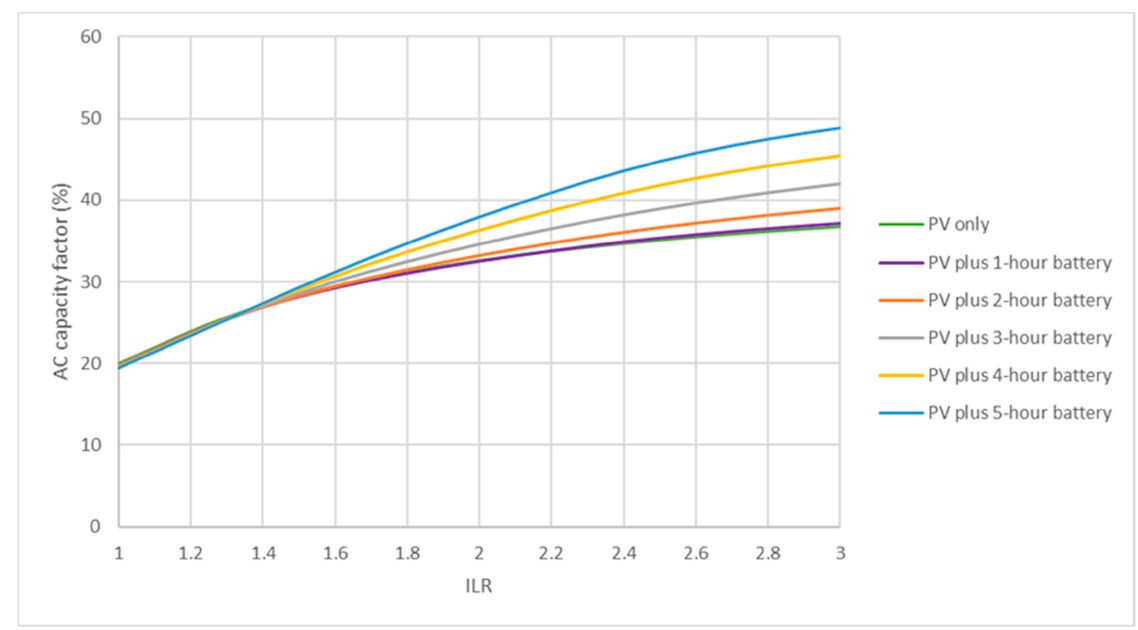
Figure 6. Variation of AC capacity factor with ILR for fixed-tilt systems.